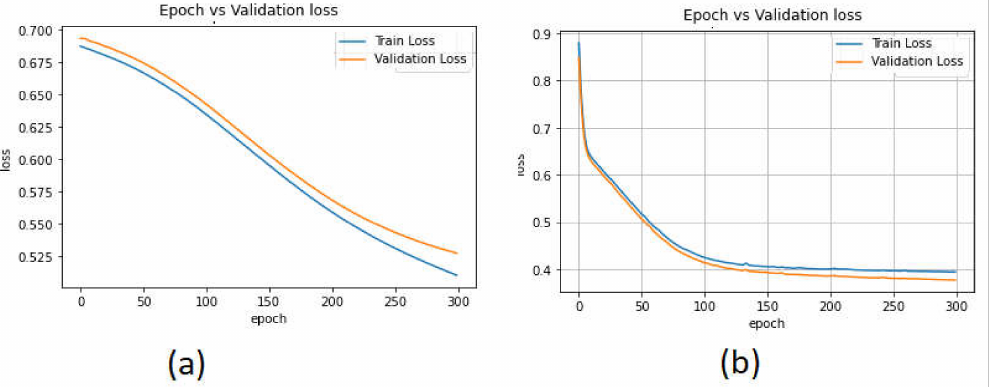
Figure 18. Accuracy loss of the autoencoder model in the ( a ) CICAndMal2017 and ( b ) Drebin